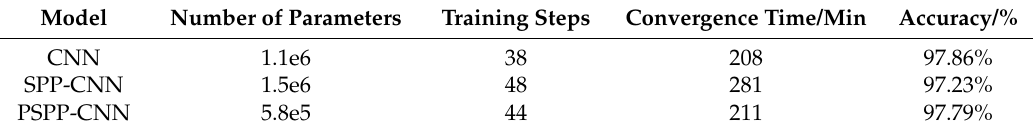
Table 5. Convergence and accuracy of Convolutional neural networks.